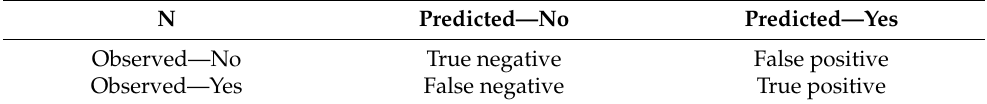
Table 1. Categorization and summary of prediction models for hot pepper disease. N Predicted—No Predicted—Yes Observed—No True negative False positive Observed—Yes False negative True